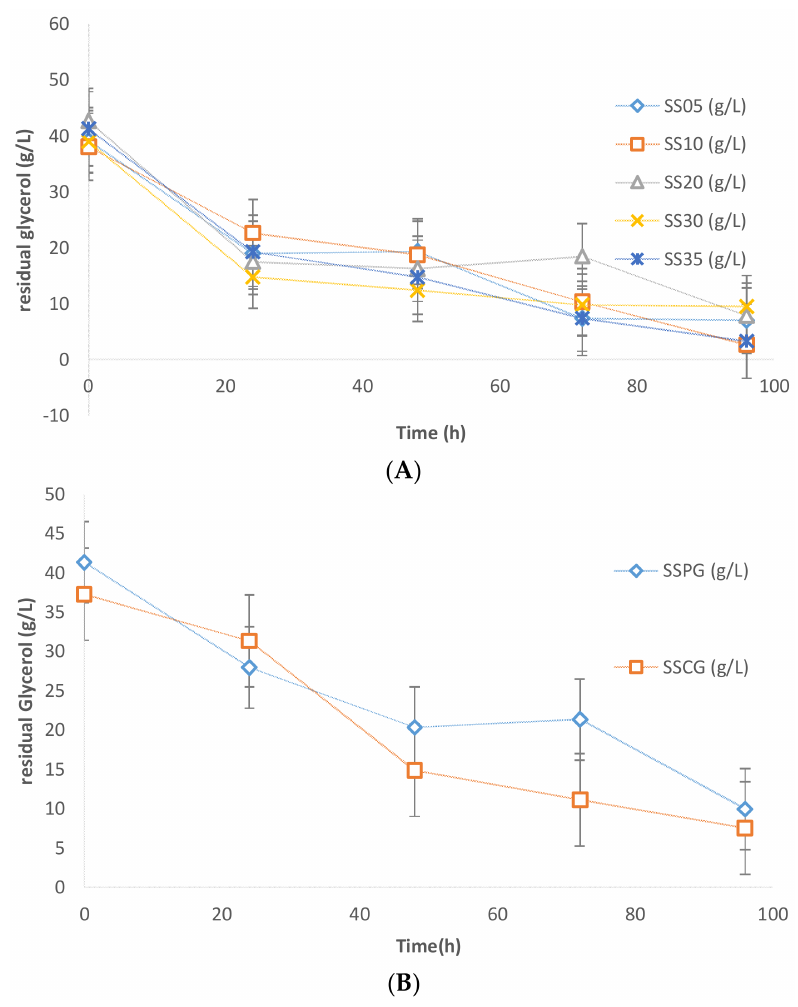
Figure 5. Glycerol consumption profile for ( A ) Flask fermentations at different sludge solid concentrations; ( B ) Flask fermentation without sludge to compare pure glycerol (SSPG) and crude glycerol